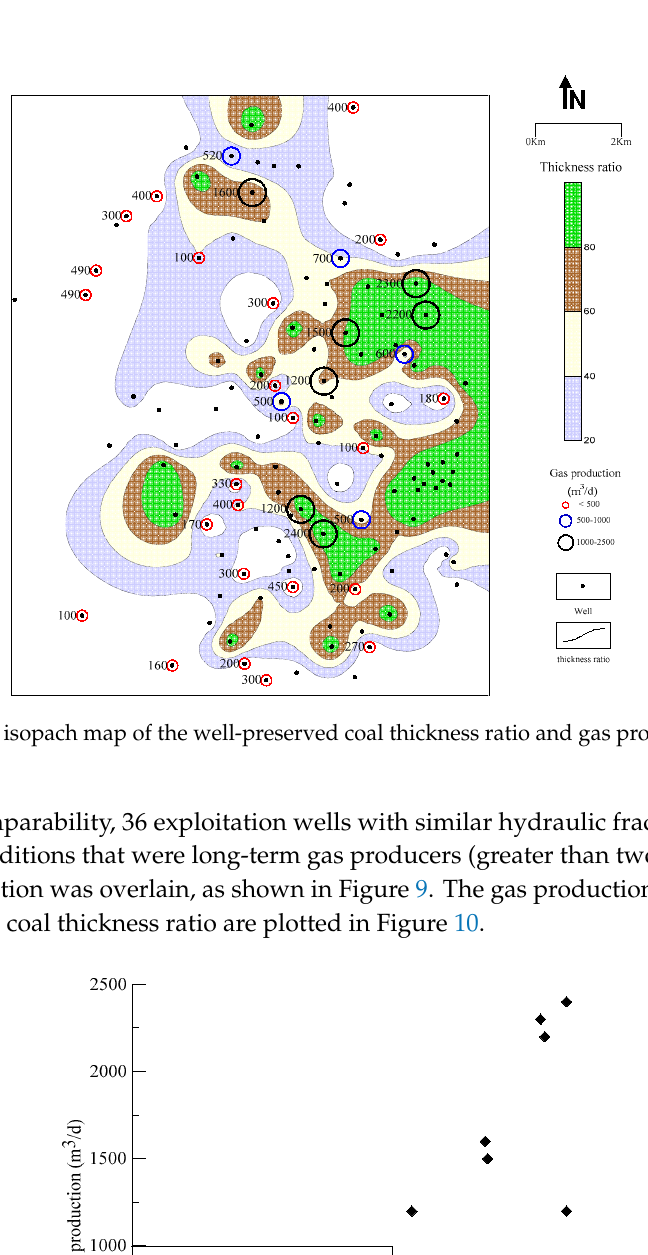
Figure 10. The thickness ratio of well-preserved coal vs. gas production of the No. 11 coal seam in 36 exploitation wells.